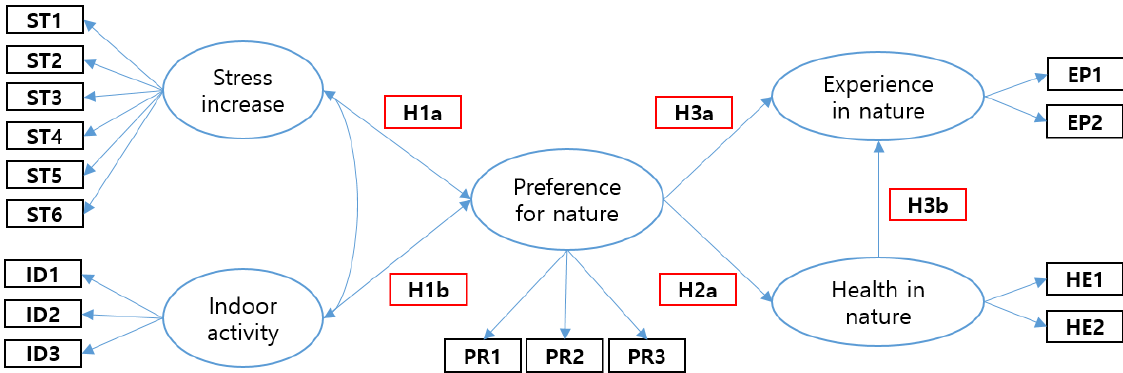
Figure 1. Structural Equation Modeling Diagram.